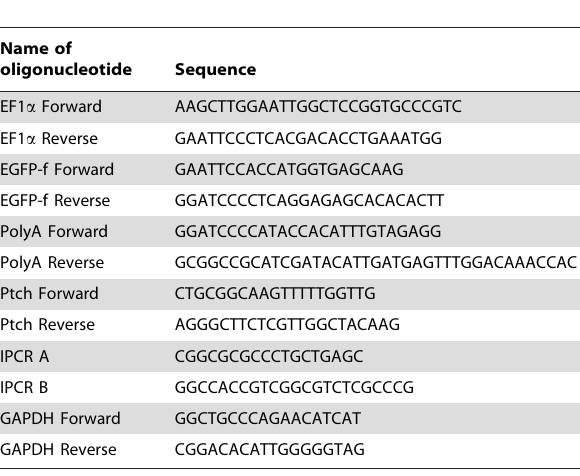
Table 3. List of oligonucleotides used for PCR